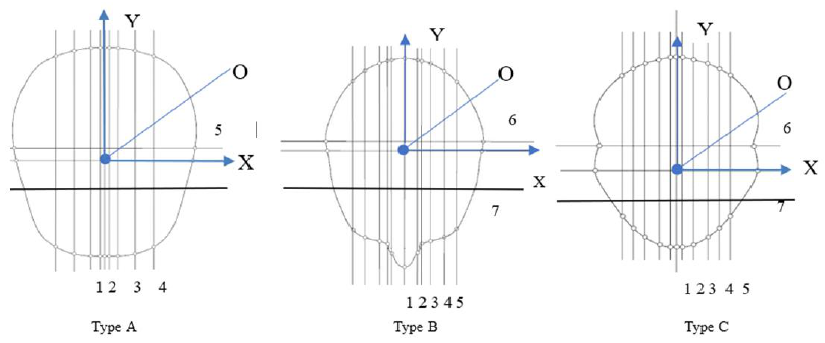
Figure 7. Type of curve.